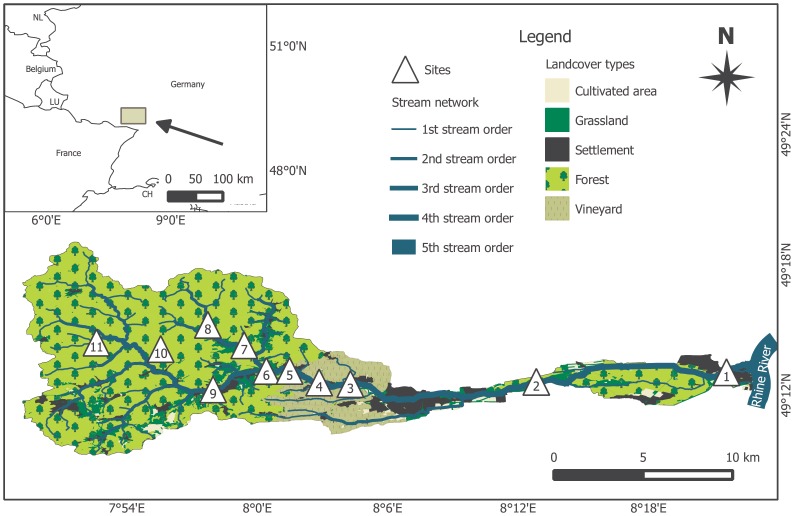
Locations of the study impoundments in the Queich River catchment area.